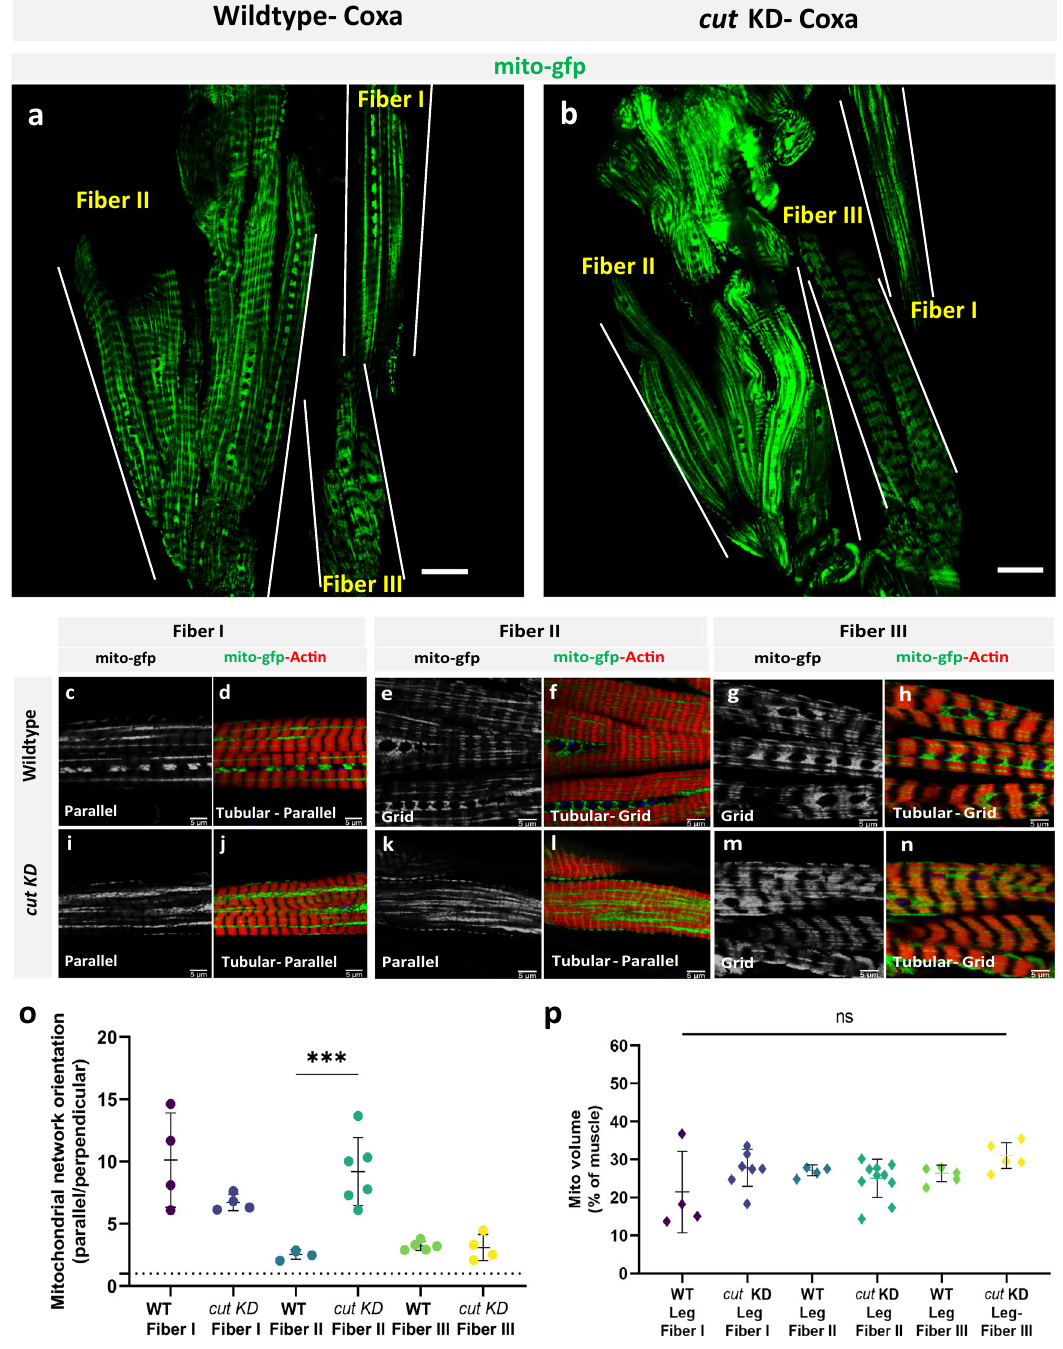
Fig. 6 | cut regulates conversion ofmitochondrial networks con fi guration, but not contractile type, in Fiber II of Drosophila leg muscles. a Adult wildtype leg coxamusclesshowingdistinctparallelandgrid-likemitochondrialnetworks(mito- gfp) in Fiber I, II, and III (demarcated by dotted lines). b cut KD converts grid-like mitochondrial networks to parallel in Fiber II (ScaleBars: 20 μ m). c , d Wildtypeleg Fiber I showing parallel mitochondrial networks (mito-GFP) and tubular muscle fi ber (phTRITC). e , f Wildtype leg Fiber II and g , h Fiber III showing grid-like mito- chondrialnetworks(mito-GFP)andtubularmuscle fi ber(phTRITC). i , j cut KDFiber I showing parallel mitochondrial networks (mito-GFP) and tubular muscle fi ber showing grid-like mitochondrial networks (mito-GFP) and tubular muscle fi bers